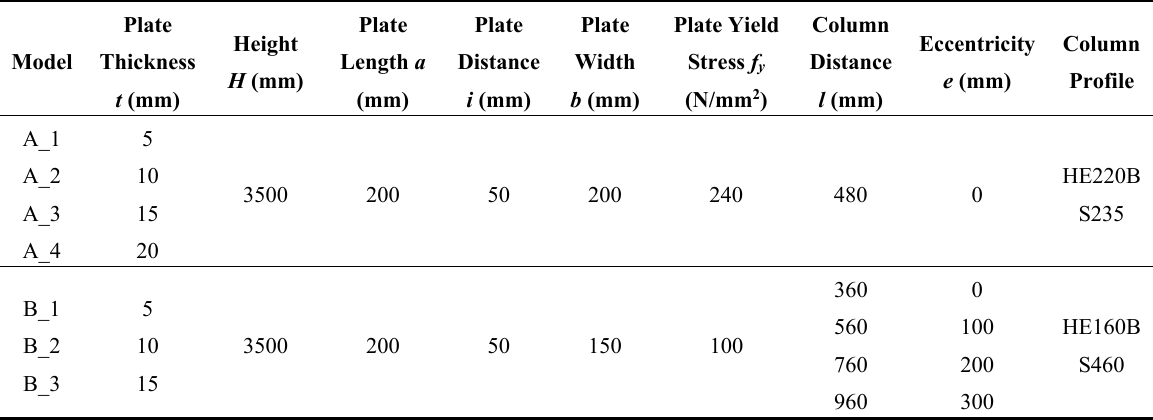
Table 1. Geometrical and structural properties of the Dissipative Column (DC)